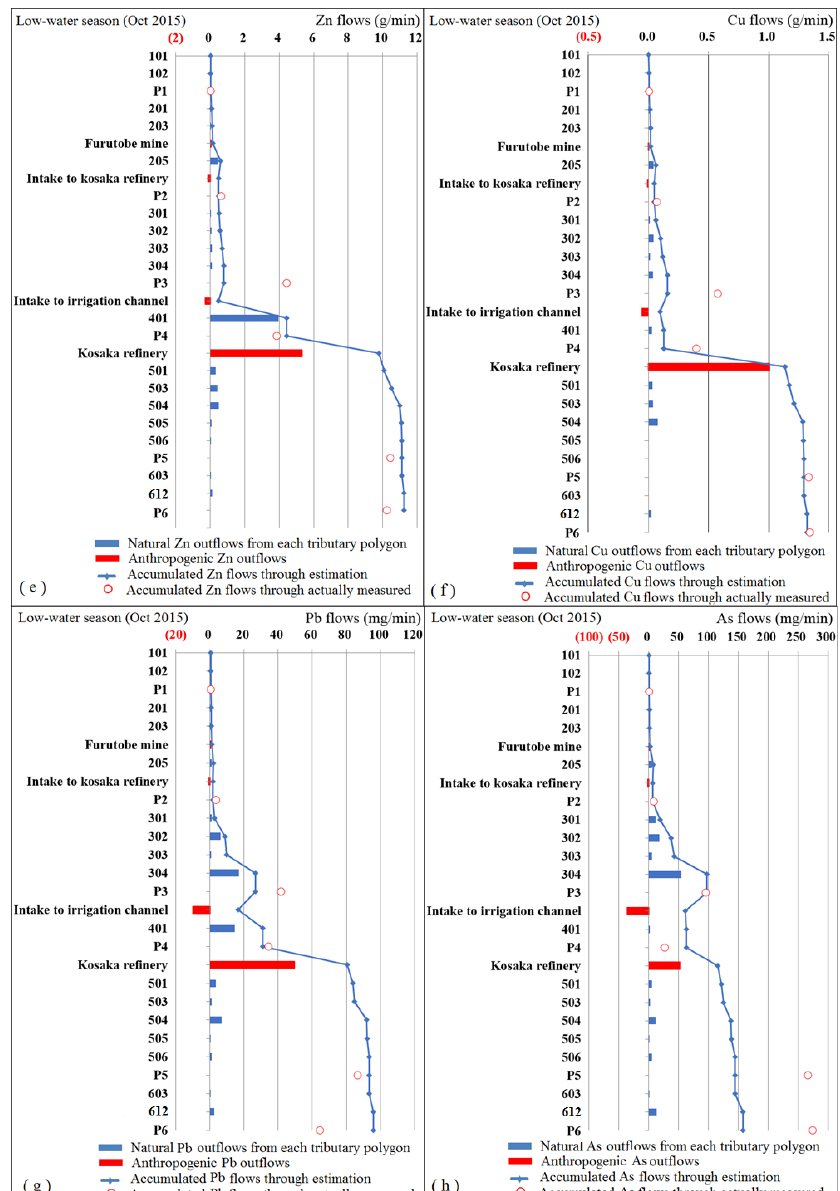
Figure 7. Zn, Cu, Pb and As outflows or inflows to the mainstream Kosaka River both in the high-water and low-water seasons: (a) Zn flows in the high-water season; (b) Cu flows in the high-water season; (c) Pb flows in the high-water season; (d) As flows in the high-water season; (e) Zn flows in the low-water season; (f) Cu flows in the low-water season; (g) Pb flows in the low-water season; (h) As flows in the low-water season. The red numbers in parenthesis are negative, standing for the outflows from the mainstream. The blue bars stand for Zn, Cu, Pb and As outflows of the non-point source part, corresponding to the natural outflows from each tributary polygon. The red bars stand for the point sources, expressing the outflows caused by human activities. The blue lines stand for the accumulated Zn, Cu, Pb and As flows of the upstream watershed. The small red circles stand for the observed Zn, Cu, Pb and As flows at the monitoring points.